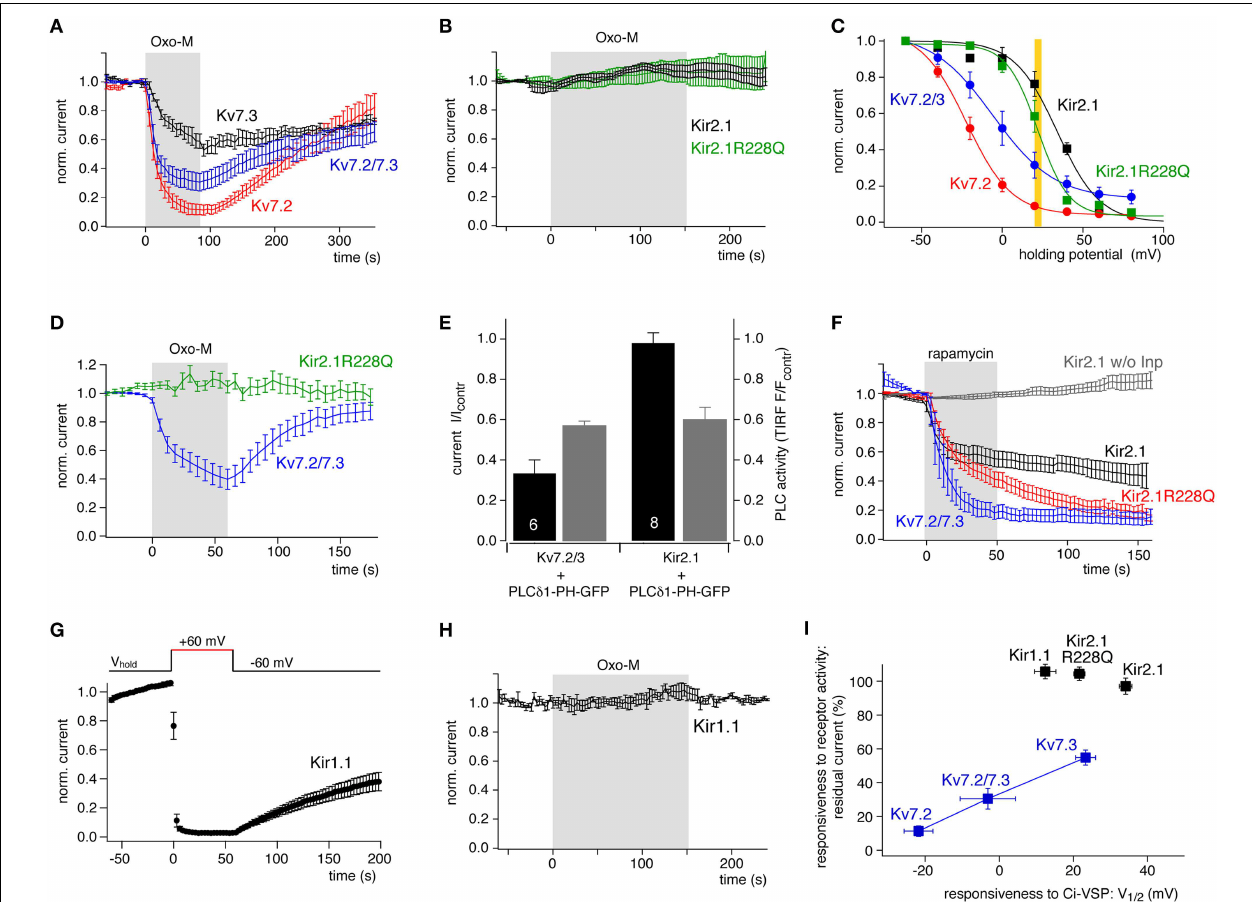
were recorded simultaneously by whole-cell patch clamp and TIRF microscopy, respectively. Current or fluorescence amplitudes at the end of a 120s application of Oxo-M are shown normalized to baseline signals immediately before activation of M1R (control). Note that the degree of PLC activity as reported by the reduction in the TIRF fluorescence is equal in experiments with both channels. Shown are mean ± SEM, numbers of independent experiments (cells) as indicated by numbers in the black bars. (F) Chemical recruitment of a specific PI(4,5)P 2 5-phosphatase (Inp54p) by application of 5 µ M rapamycin (5 µ M) induces inhibition of Kir2.1, Kir2.1(R228Q), and Kv7.2/7.3 channels in CHO cells (mean ± SEM, N = 9 , 12, and 5, respectively). Lack of inhibition of Kir2.1 in cells without co-expression of the phosphatase construct (w/o Inp; gray; N = 7 ), demonstrates that inhibition results from depletion of PI(4,5)P 2 but not from direct inhibition of the channel by rapamycin. (G) Kir1.1 channels expressed in CHO were strongly inhibited by co-expressed Ci-VSP. Voltage protocol as in Figure 1 (mean ± SEM; N = 11 cells). (H) Kir1.1 channels were insensitive to stimulation of co-expressed M1R in CHO cells (mean ± SEM; N = 4 cells). (I) Sensitivity of the various channels to PLC/receptor-mediated depletion of PI(4,5)P 2 plotted vs. the sensitivity to activation of Ci-VSP (V 1 / 2 ). A correlation is observed only for Kv7 channel isoforms. V 1 / 2 (Ci-VSP) for Kir1.1 channels was obtained as shown for Kir2.1 in Figure 1